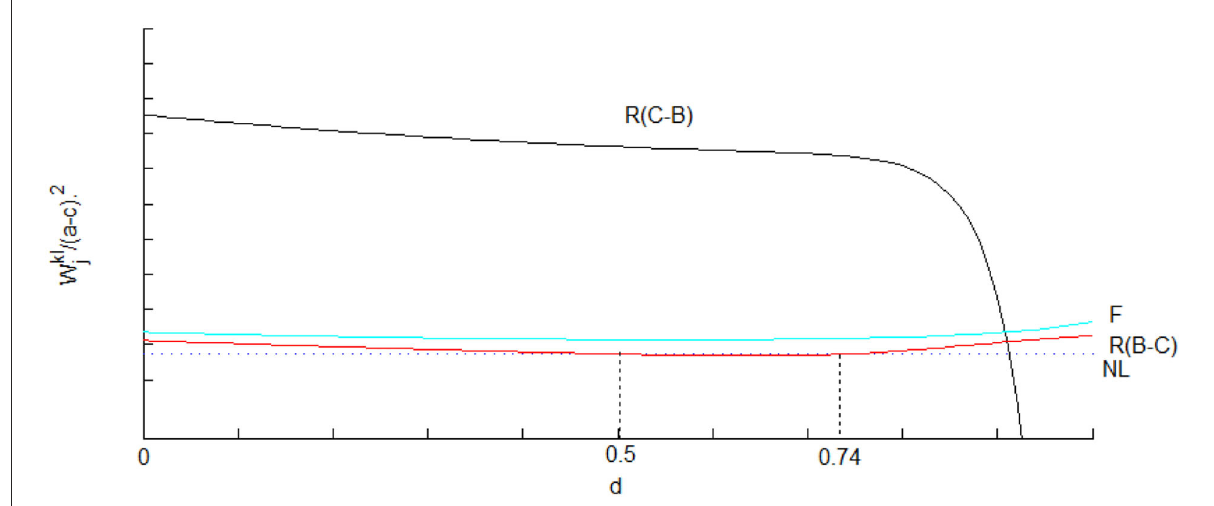
FIGURE4 Society welfare in different licensing methods under mixed